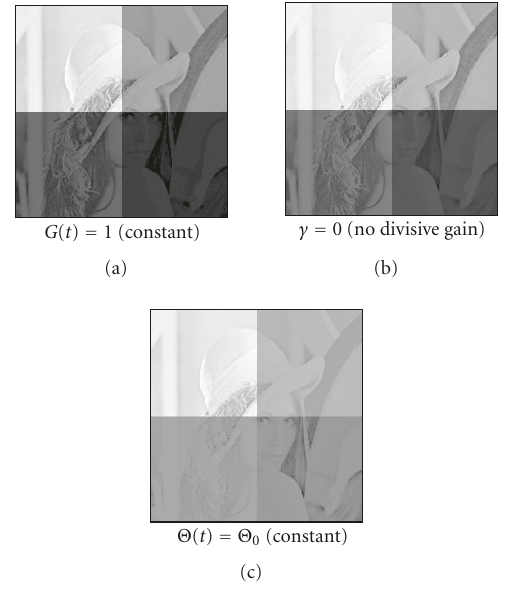
Figure 3: Artifacts : the results shown in this figure should be com- pared with Figure 7. (a) Setting the amplification constant to G ( t ) = 1 in (2) diminishes adaptation (i.e., low luminance values are not pushed that high). Notice that in this case dynamical switching is made inoperative. (b) Setting γ = 0 in (3) has no e ff ect on the nat- ural images we have tested, but causes strong ripple artifacts with luminance ramps as demonstrated in Figure 2. (c) Using a constant threshold Θ ( t ) = Θ 0 = 0 . 25 in (5) leads to strong saturation (or over-adaptation). All results are shown at t = 250